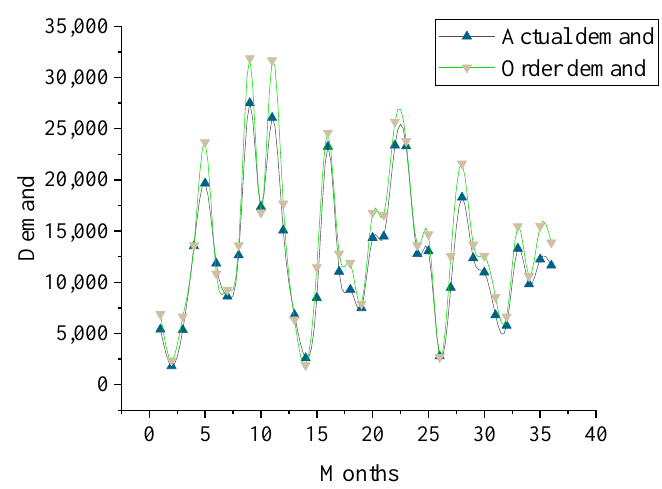
Figure 1. Demand data of enterprises with high capability maturity .